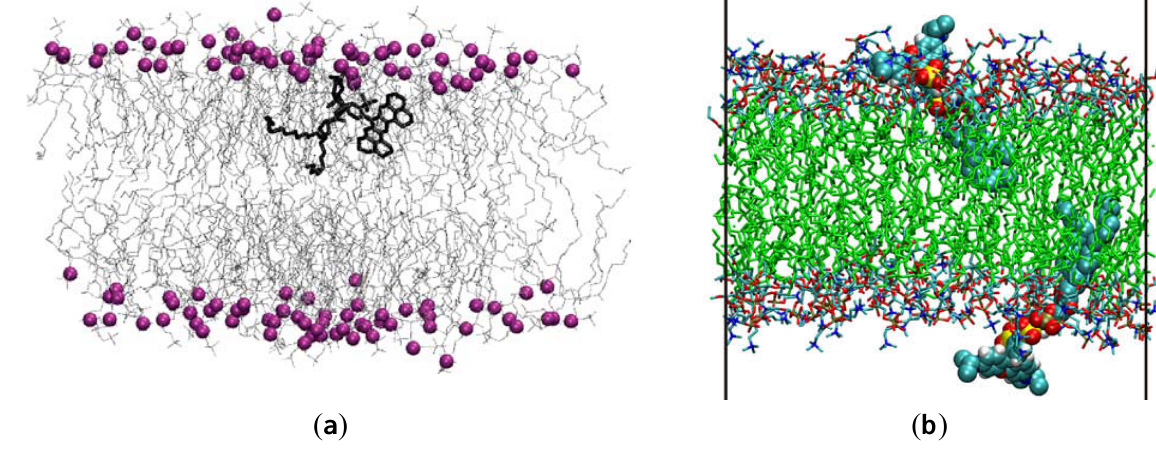
Figure 5. Snapshots of simulations of polar-fluorophore headgroup-labeled phospholipid probes in fluid DPPC bilayers. Water molecules are omitted in both panels. ( a ) 1 TR-DHPE:127 DPPC bilayer [39]. The DPPC phosphorus atoms, purple spheres, are highlighted to show the location of the headgroups. The entire TR-DHPE molecule is shown in thick black. Reprinted with permission from [39]. Copyright 2009 American Chemical Society. ( b ) 2 Rhod-DPPE:126 DPPC bilayer [40]. The Rhod-DPPE